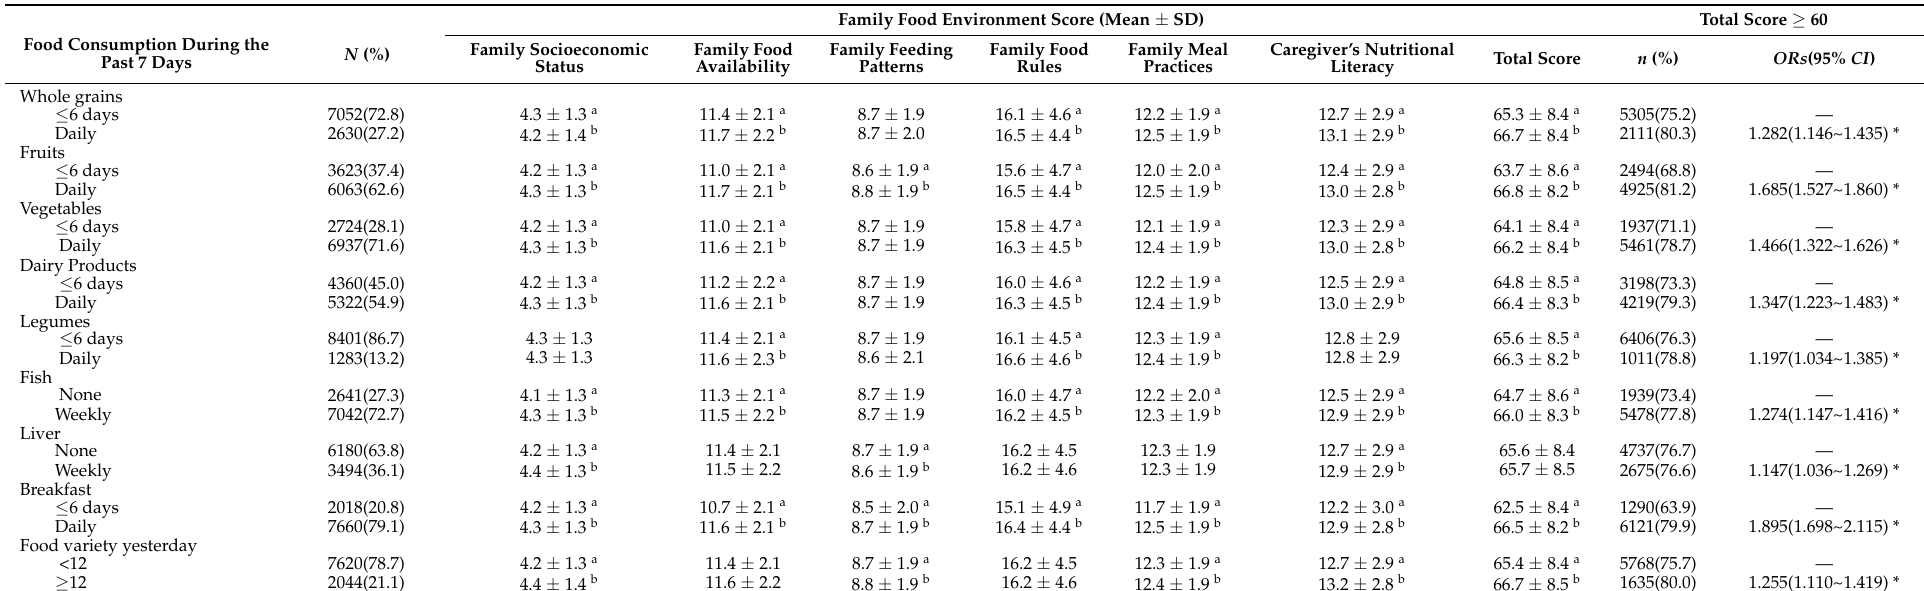
Table 3. Healthy Food Consumption in Relation to Family Food Environment.